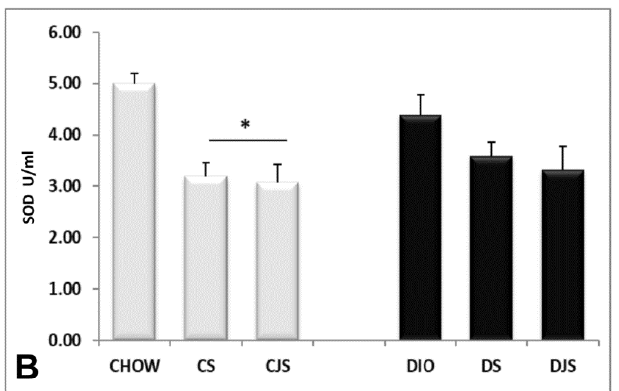
Figure 3. Concentrations of ( A ) malondialdehyde (MDA) and ( B ) superoxide dismutase (SOD) activity in the serum. MDA concentrations are expressed in µ M and SOD activity are expressed in unit / mL(U / mL), where one unit is defined as amount of enzyme needed to exhibit 50% dismutation of